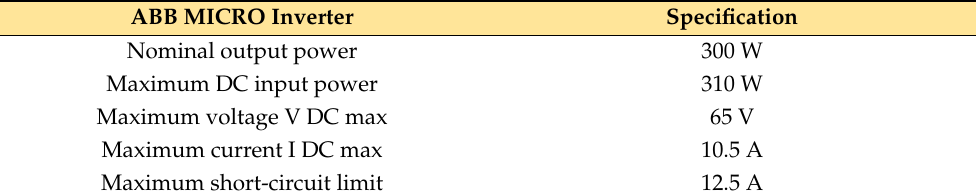
Figure 8. MICRO-0.3-I-OUTD-230. Table 4. Micro-inverter specifications—MICRO-0.3-I-OUTD-230.